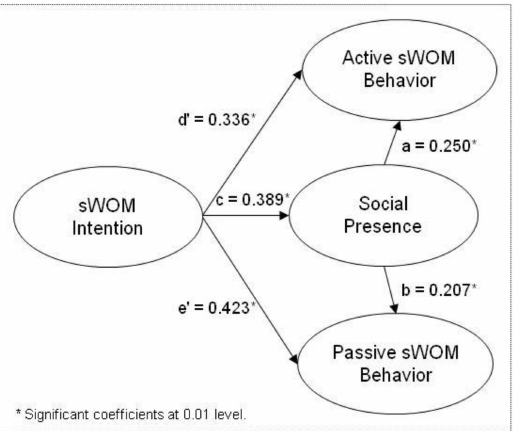
Figure 4. Structure of the relationships for exploring mediating effects: model with mediating effects of social